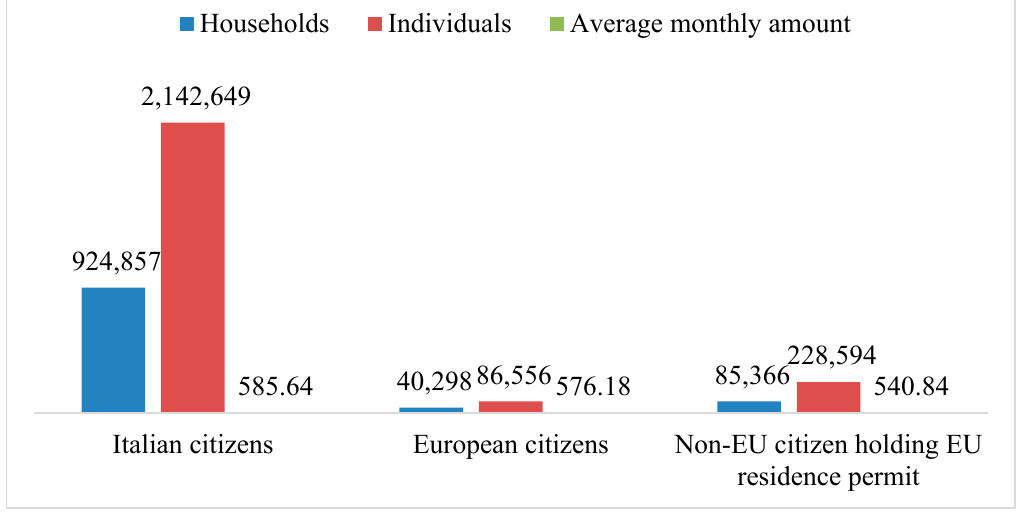
Figure 14. RdC per geographical origin, by household, individuals, and average monthly amount, 2022. Source: own elaboration on the INPS database.